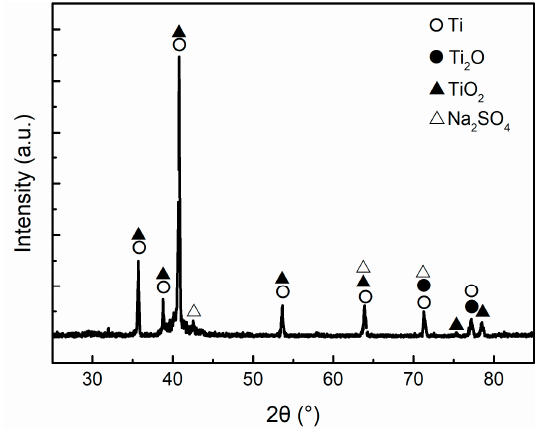
Figure 13. XRD diffractogram of Ti-6Al-4V alloy after hot corrosion for 4 h. Figure 15 is the XRD diffractogram of Ti-6Al-4V alloy after hot corrosion for 88 h, in which Al 2 O 3 phase appeared, indicating that the Al segregation and alloy oxidation were aggravating.